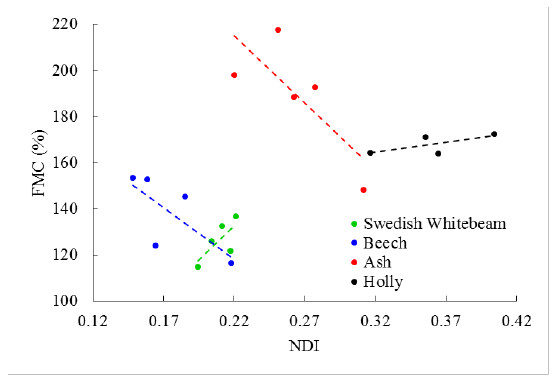
Figure 2. The determined NDI – FMC relationships.